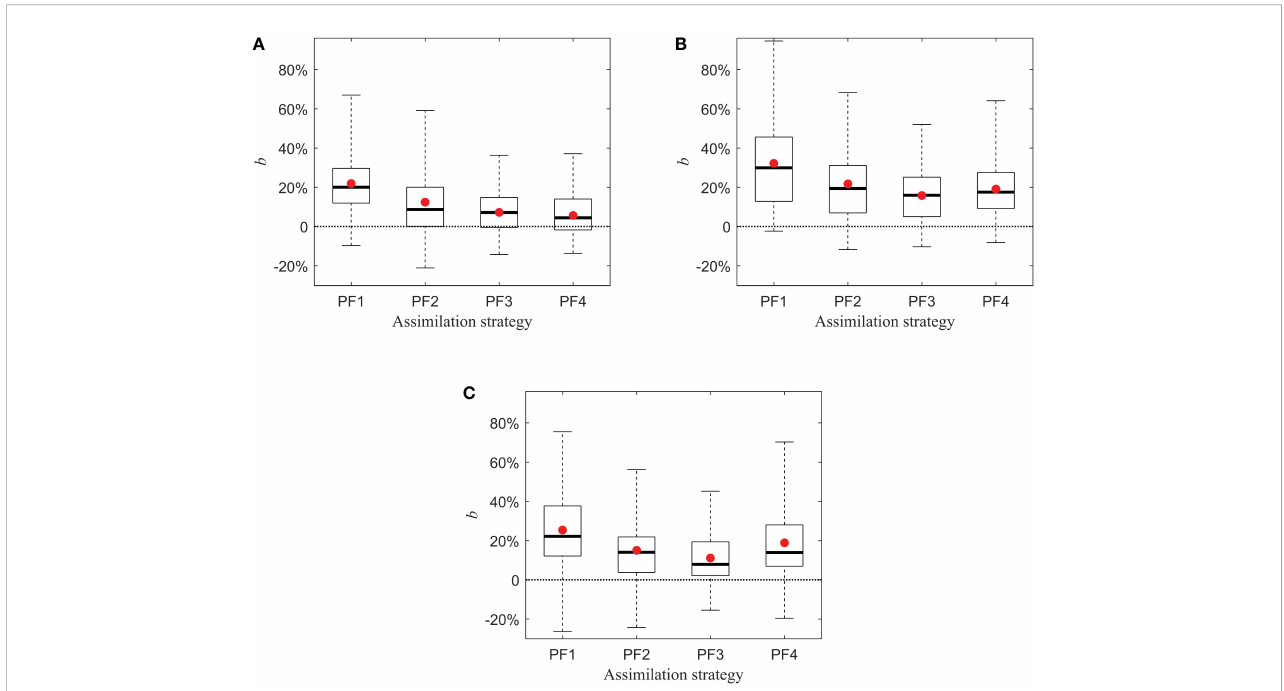
FIGURE 3 The box plots of b for the PF1, PF2, PF3, and PF4 assimilation strategies using (A) LICOM3 data, (B) GLORYS2V4 data, and (C) AVISO data, with respect to selected eddies and 10 groups of observations for each